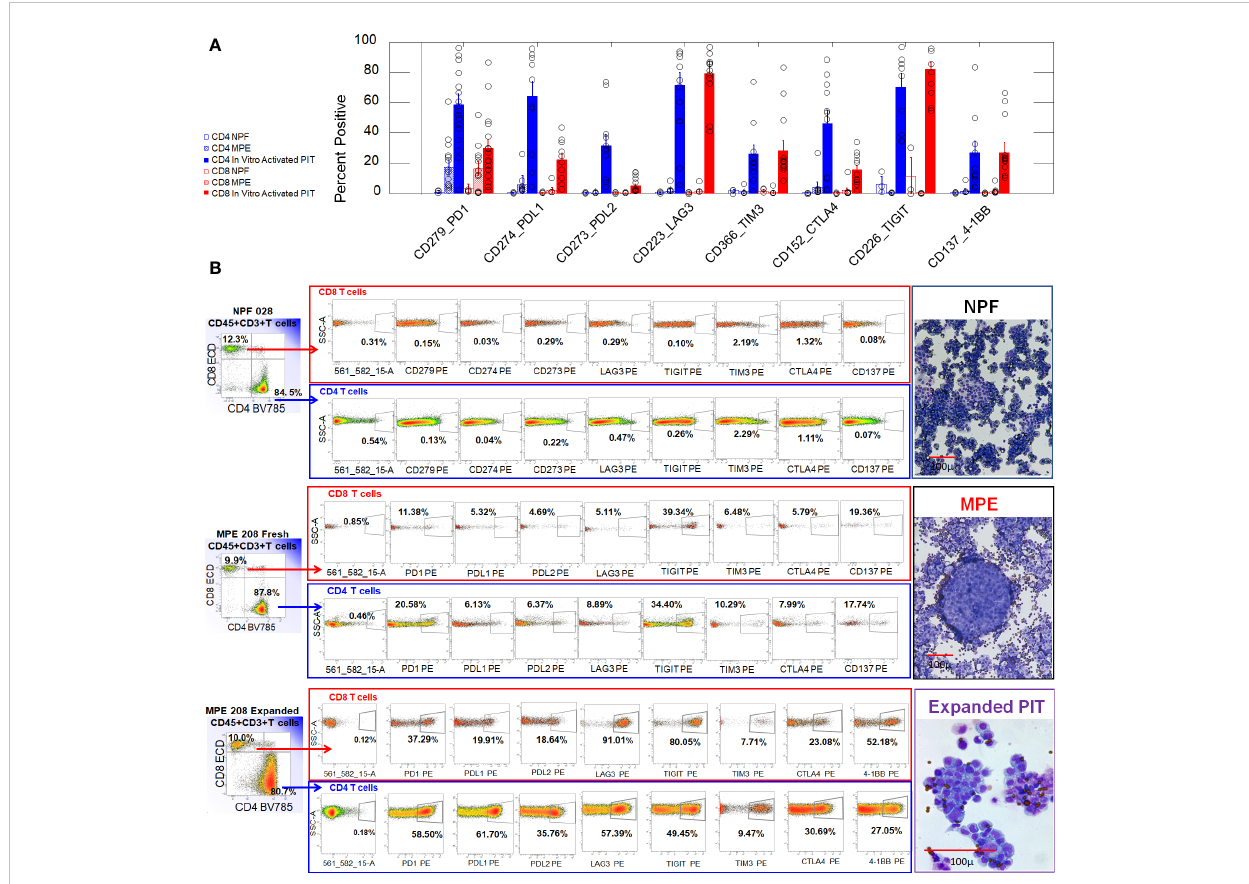
FIGURE 1 Expression of ICM on CD4+ and CD8+ T cells from normal pleural fl uid, freshly drained MPE and in vitro activated non-adherent MPE cells. (A) Bar graph summarizing results from 3 NPF (2 valve replacement, 1 aortic aneurism), 13 MPE (serial samples from MPE205 Breast Cancer (ER+PR+Her2+), MPE208 Breast Cancer (ER+PR-), MPE212 Breast Cancer (ER+PR+Her2-), MPE211 Renal Cell Carcinoma), and 17 in vitro activated PIT (same subjects). Error bars indicate standard errors of the means. (B) Representative histograms used to generate the bar graph shown in Panel (A) . The parent gate for CD4 and CD8 T cells was CD45+, CD3+ singlet cells (not shown). Illustrative cytocentrifuge preparations of freshly isolated normal pleural fl uid (NPF) and a breast cancer malignant pleural effusion (MPE), and in vitro activated PIT (Wright Giemsa stain) are shown to the right of the histograms. The smallest dark circles in NPF and MPE are lymphocytes. The sheets of large cells in NPF are shed mesothelial cells. The large cluster of cells in MPE is a tumor cell nest. In vitro activated PIT are characterized by proliferating cell clusters and are shown at a higher magni fi cation: the small dark circles are CD3/CD28